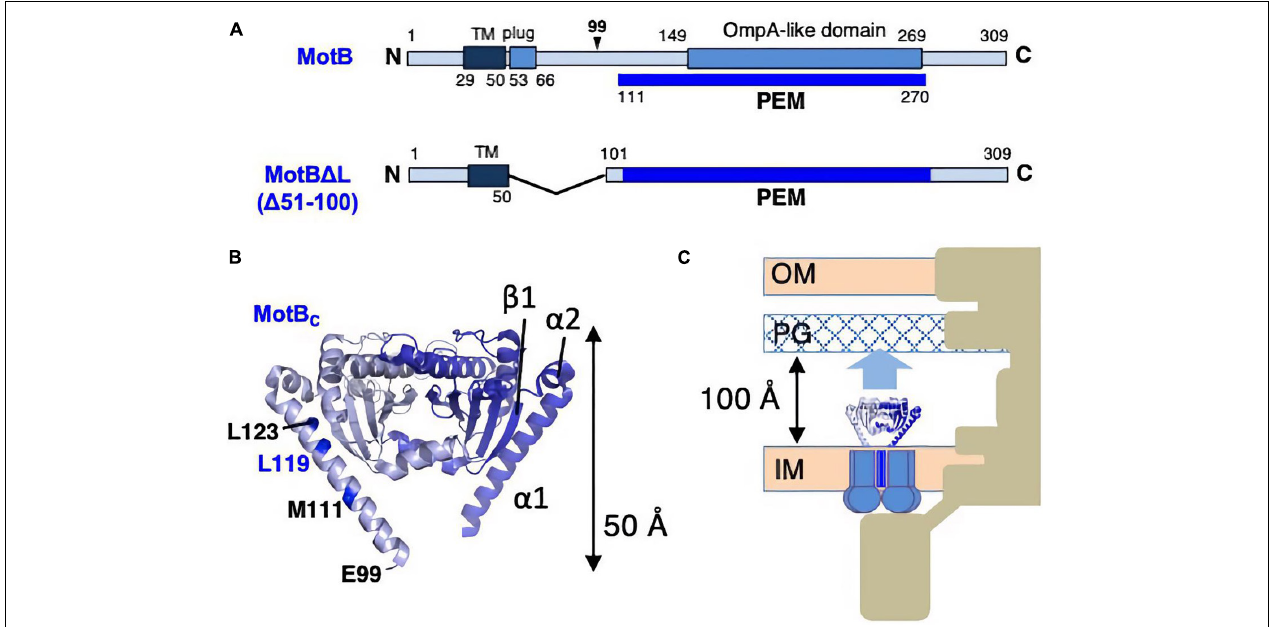
FIGURE 4 | (A) Primary structures of Salmonella enterica MotB; the PEMs for MotB are shown by the blue lines below each primary structure. (B) Dimer structures of the periplasmic fragments (MotB C ) of Salmonella MotB (PDB: 2ZVY). (C) Schematic drawing of the compact conformation of the stator complex composed of MotA and MotB (cid:49) L. OM, outer membrane; IM, inner membrane; PG, peptidoglycan